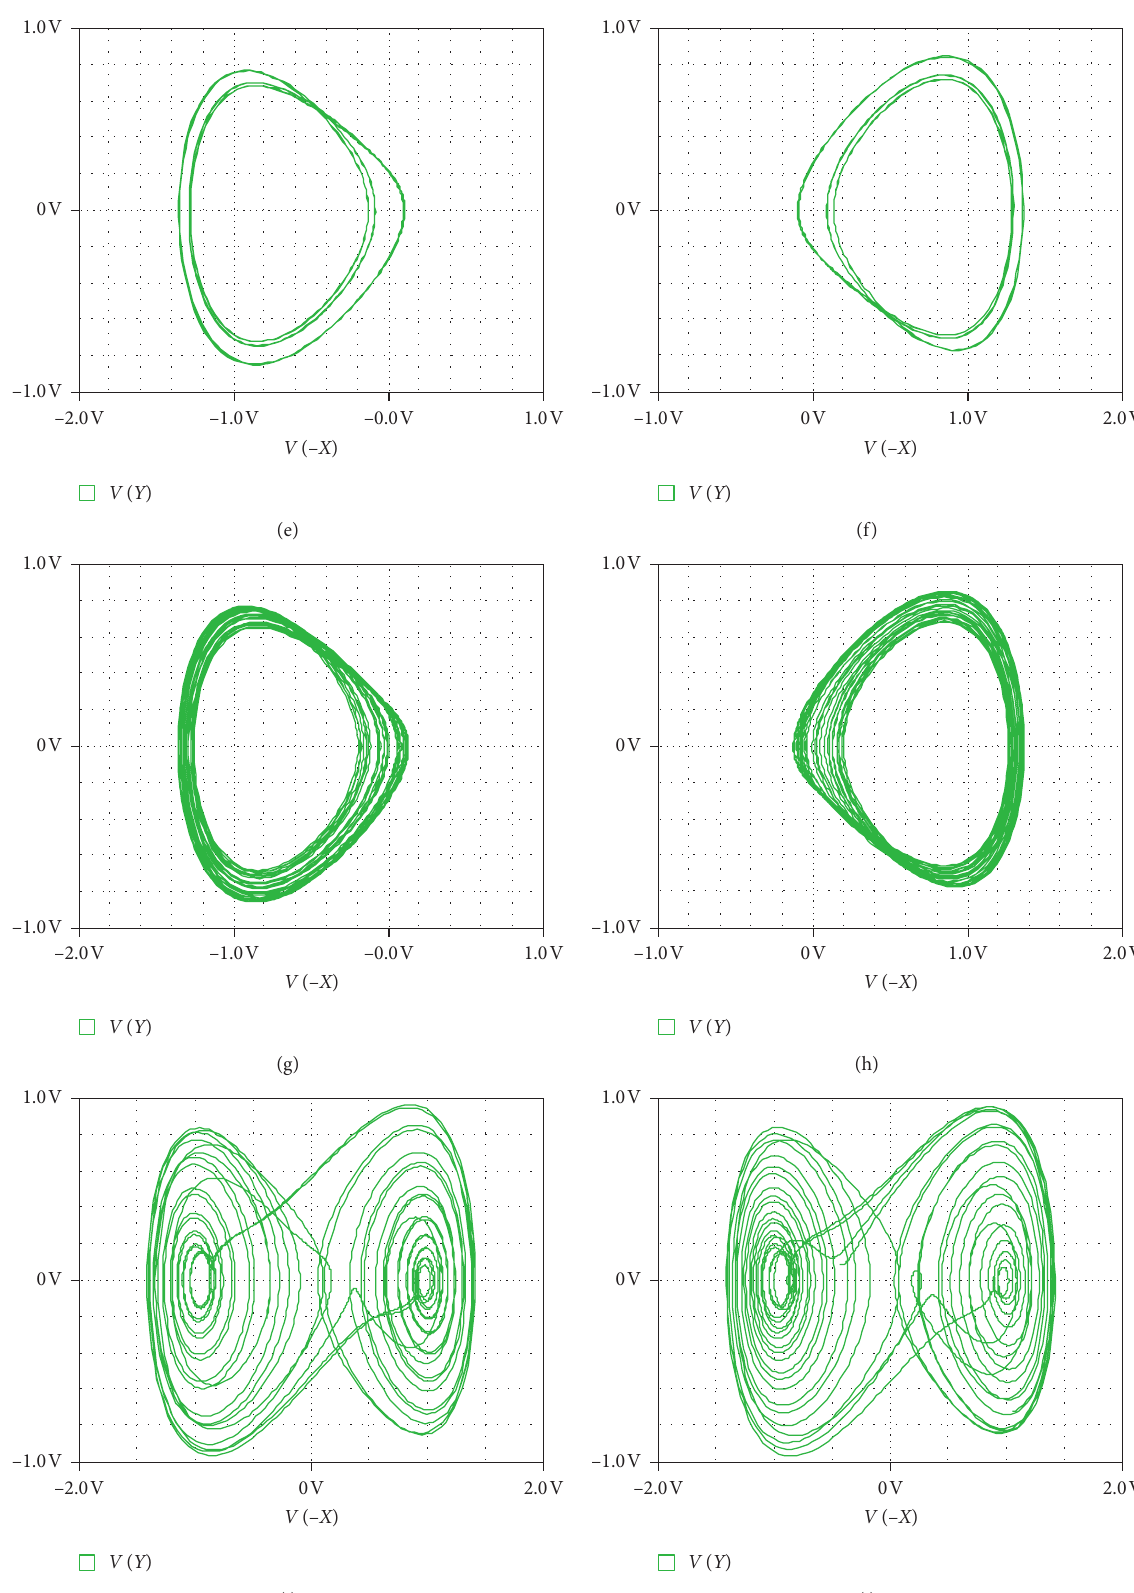
Figure 15: Phase portraits obtained from PSpice for R � 1 M Ω (corresponding to the symmetric case) and different values of the control m resistance R b showing (a) cycle of period-1 for R b � 45k Ω , (b) cycle of period-2 for R b � 35 . 6 k Ω , (c) cycle of period-4 for R b � 35 . 4 k Ω , (d) single chaotic band for R b � 35k Ω , and (e) double-band chaotic attractor R b � 33 . 33 k Ω . The pairs are obtained for ( X ( 0 ) ,Y ( 0 ) , Z ( 0 )) � ( ± 0 . 25 , 0 , 0 )